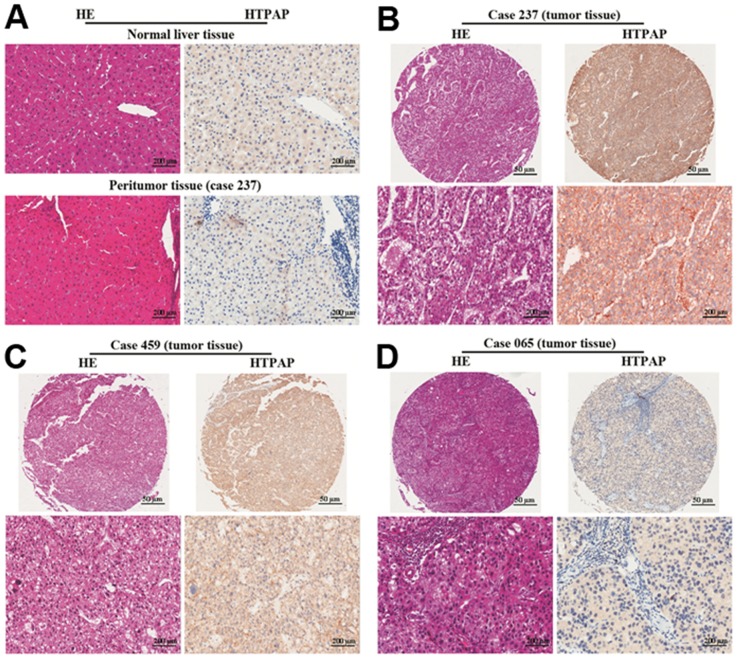
Tissue microarray analysis of HTPAP expression in groups of HCC with promoter I, II and III haplotypes.Tissue microarray analysis of HTPAP expression in HCC and normal liver tissues. Hematoxylin-eosin (HE) and weak HTPAP staining are illustrated in normal liver and peritumoral tissues (A). HTPAP protein expression was observed primarily in the cytoplasm with great variability between different tumor samples. Representative pictures of immunohistochemical staining are shown (strong, B; moderate, C; low, D). Scale bar: 50 µm, 200 µm.